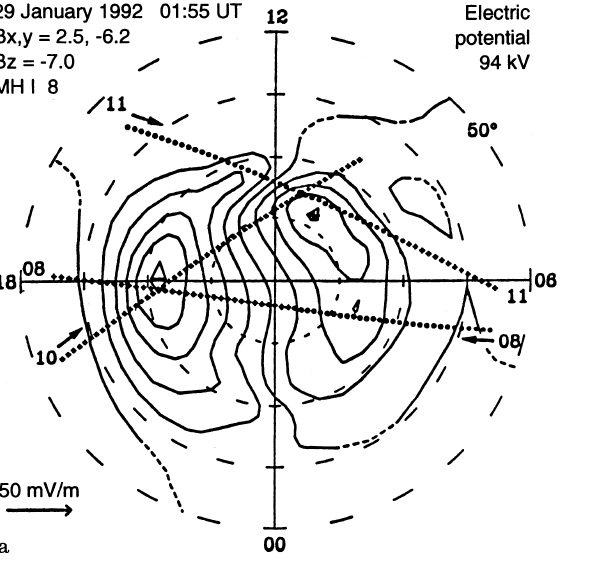
with solid lines representing the downward current and dashed lines theupwardcurrent.Thecontourintervalis0.3 (cid:108) A/m 2 ,starting (cid:139)0.1 (cid:108) A/m 2 . The total downward current integrated over the area poleward of 50 (cid:176) latitude is given at the upper right . The di(cid:128)erent magnetospheric plasma regimes are indicated by the di(cid:128)erent shadings , from Lu et al ., (1995)